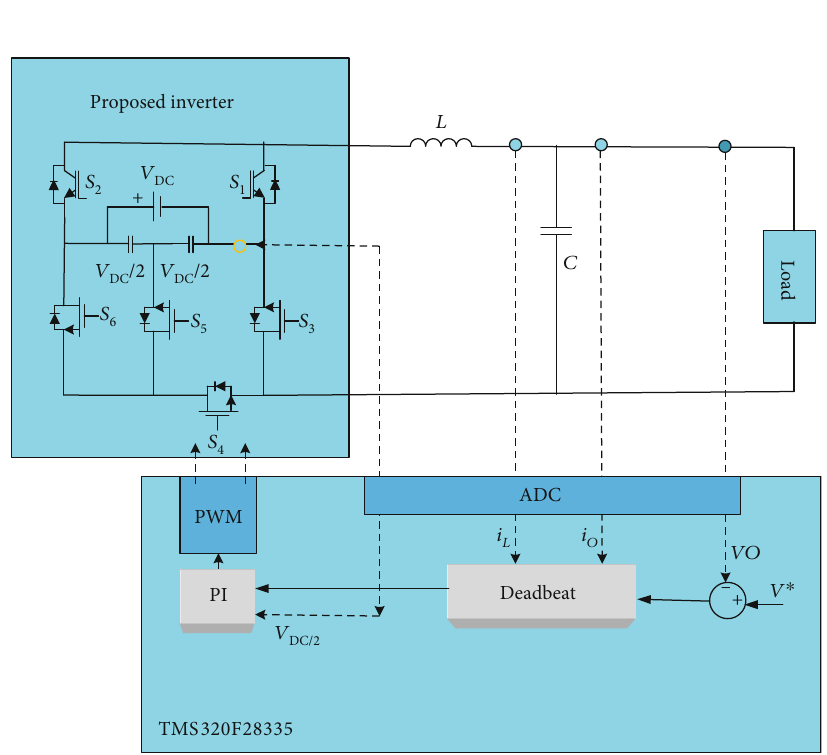
Figure 11: DC link capacitor voltage and deadbeat